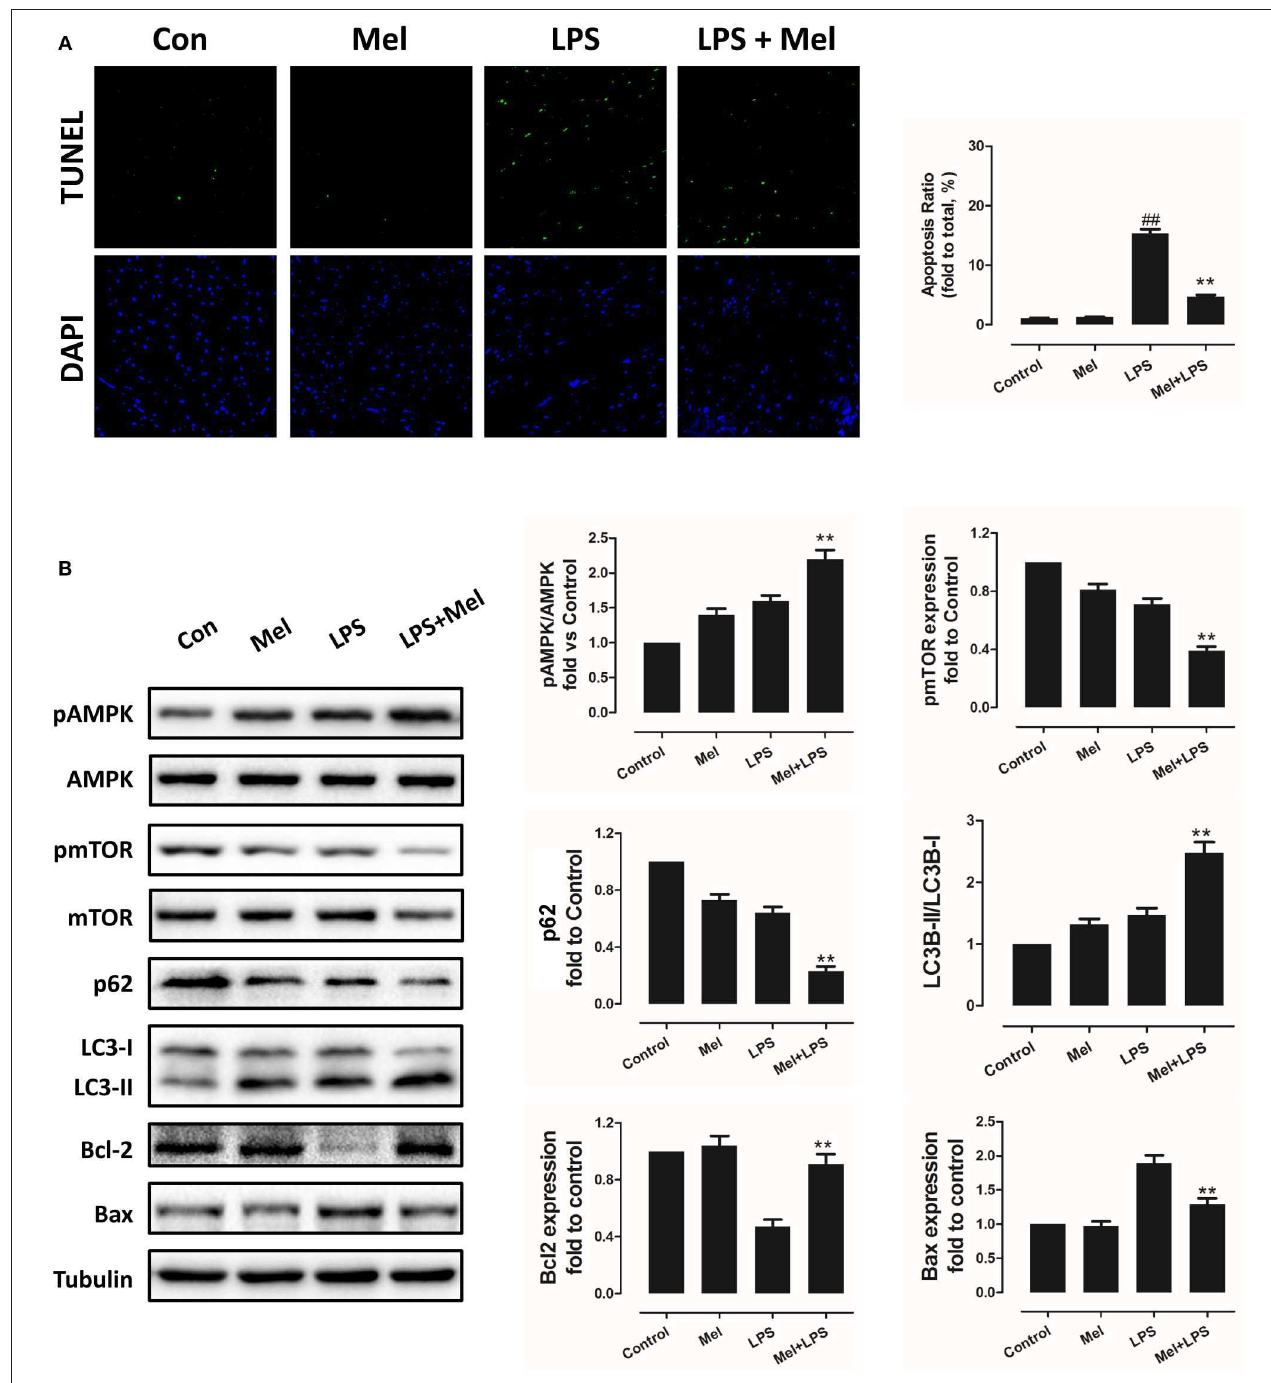
FIGURE 2 | Effects of melatonin administration on myocardial apoptosis, AMPK and autophagy pathway after LPS injury. (A) Representative images of TUNEL staining and quantitative analysis of the apoptosis ratio. (B) Representative bands of western blot and quantitative analysis of pAMPK phosphorylation level, pmTOR phosphorylation level, p62 expression, LC3B-II/LC3B-I ratio, Bcl-2 expression and Bax expression. n = 6, ** P < 0.05 vs. the LPS group, ## P < 0.05 vs. the Control group. Mel,